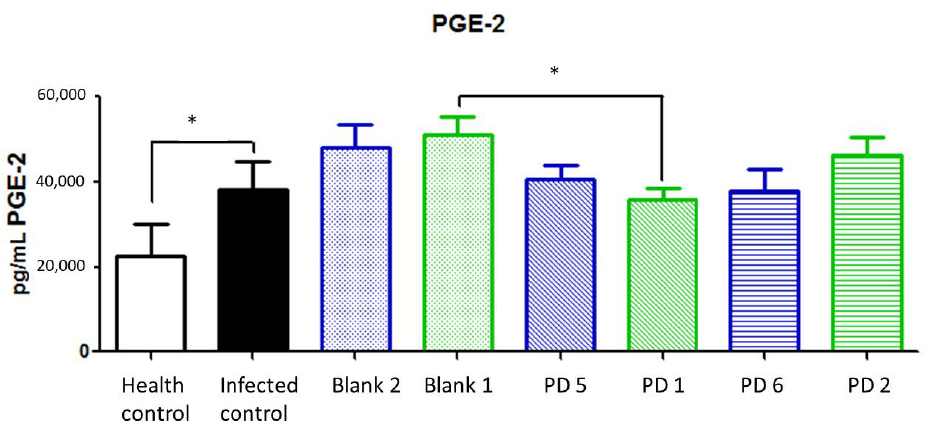
Figure 17. Prostaglandin E2 (PGE2) expression (pg/mL) in stomach after different treatments and controls. Blank 1: Mucolast ® , Blank 2: PBS. PD1: Amox 89.4 mg/kg/day, Clar 44.7 mg/kg/day in Mucolast ® . PD2: Amox 44.7 mg/kg/day, Clar 22.35 mg/kg/day in Mucolast ® . PD5: Amox 89.4 mg/kg/day, Clar 44.7 mg/kg/day in PBS. PD6: Amox 44.7 mg/kg/day, Clar 22.35 mg/kg/day in PBS. * Statistical differences at 0.05.